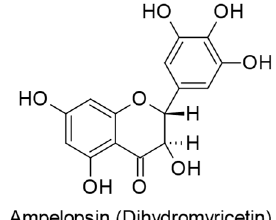
Figure 7. Chemical structure of dihydroflavonol ampelopsin with therapeutic effect against EBV- positive human Burkitt’s lymphoma cells.